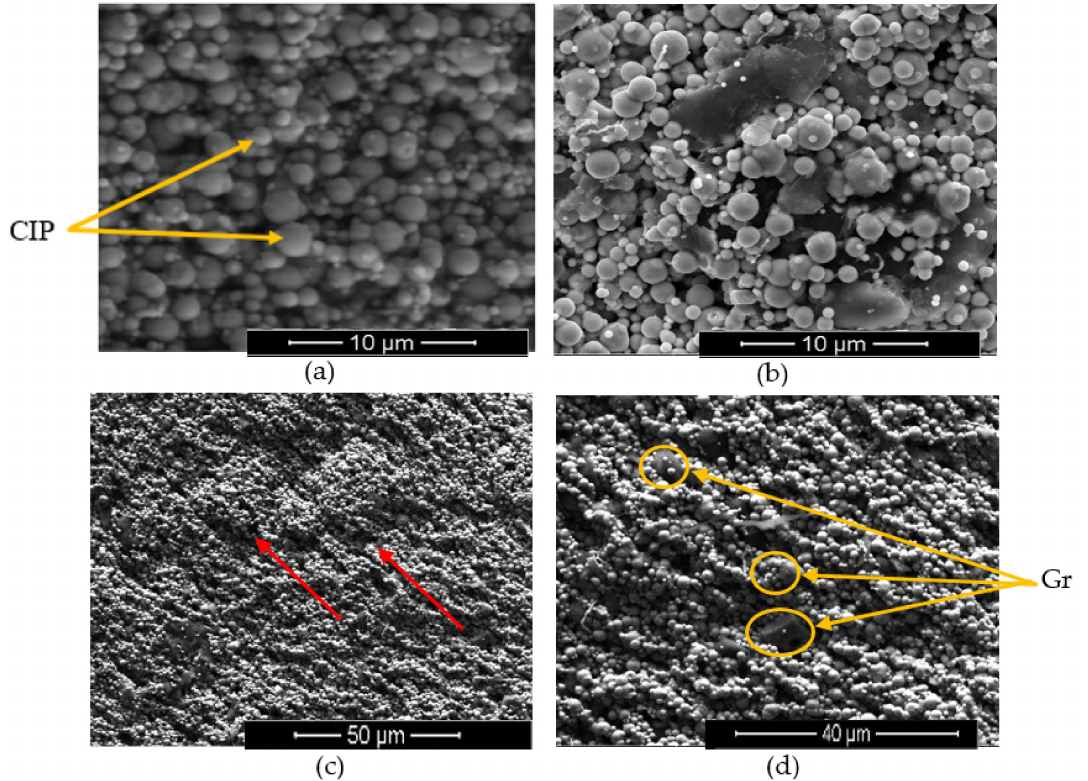
Figure 3. SEM images in the absence of magnetic field at magnification of 2500 × for ( a ) MRP and ( b ) Gr–MRP. ( c ) Chain structure formation of Gr–MRP along with the presence of magnetic field at magnification of 500 × and ( d ) enlargement of Gr in the presence of magnetic field. Red arrow represents the direction of magnetic